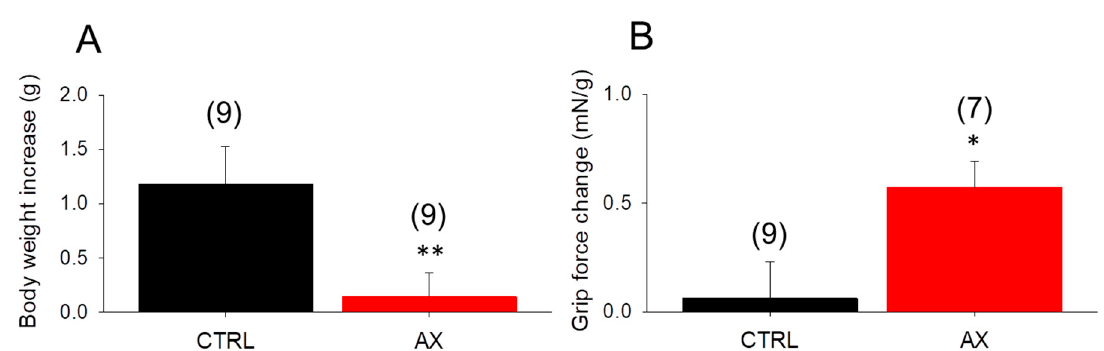
Figure 1. Significant in vivo changes following 4 weeks astaxanthin (AX) diet. ( A ) The body weight increase was less prominent in the AX group. ( B ) The increase of maximal grip force normalized to body weight was greater following AX diet. Numbers in parenthesis denote the number of animals. Averages of values were measured on the first and last day of AX diet. Significant differences between CTRL and AX were marked with * p < 0.05 and ** p < 0.01, respectively.